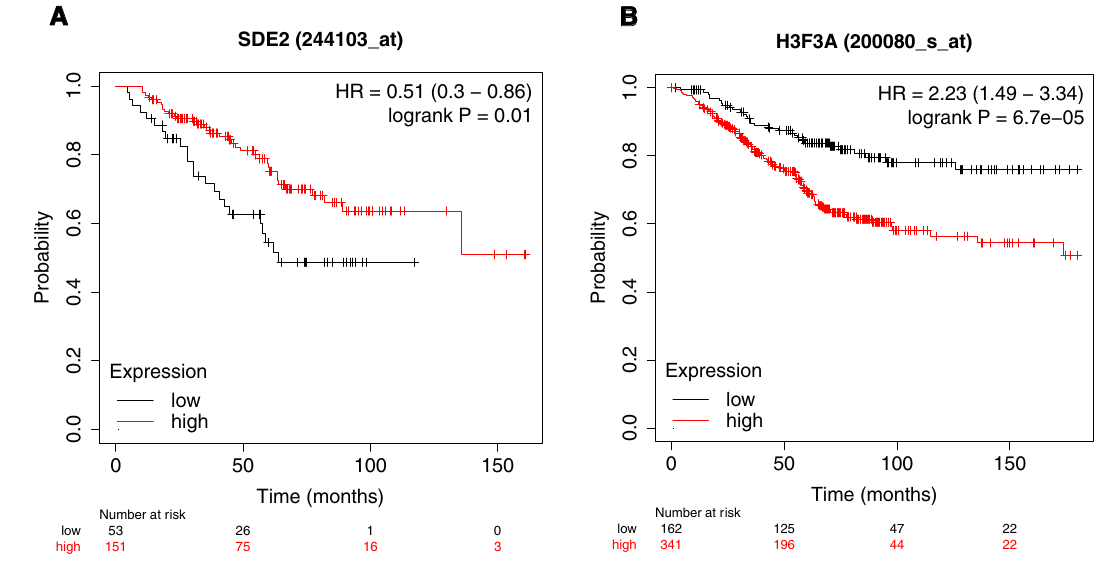
Figure 3. Kaplan–Meier overall survival plot for high versus low expression level of the genes ( A ) SDE2 (n = 204) and ( B ) H3F3A (n = 503) restricted to patients with a grade 3 tumor and 15 years of follow-up. The differential expression analysis was performed in KMplotter.